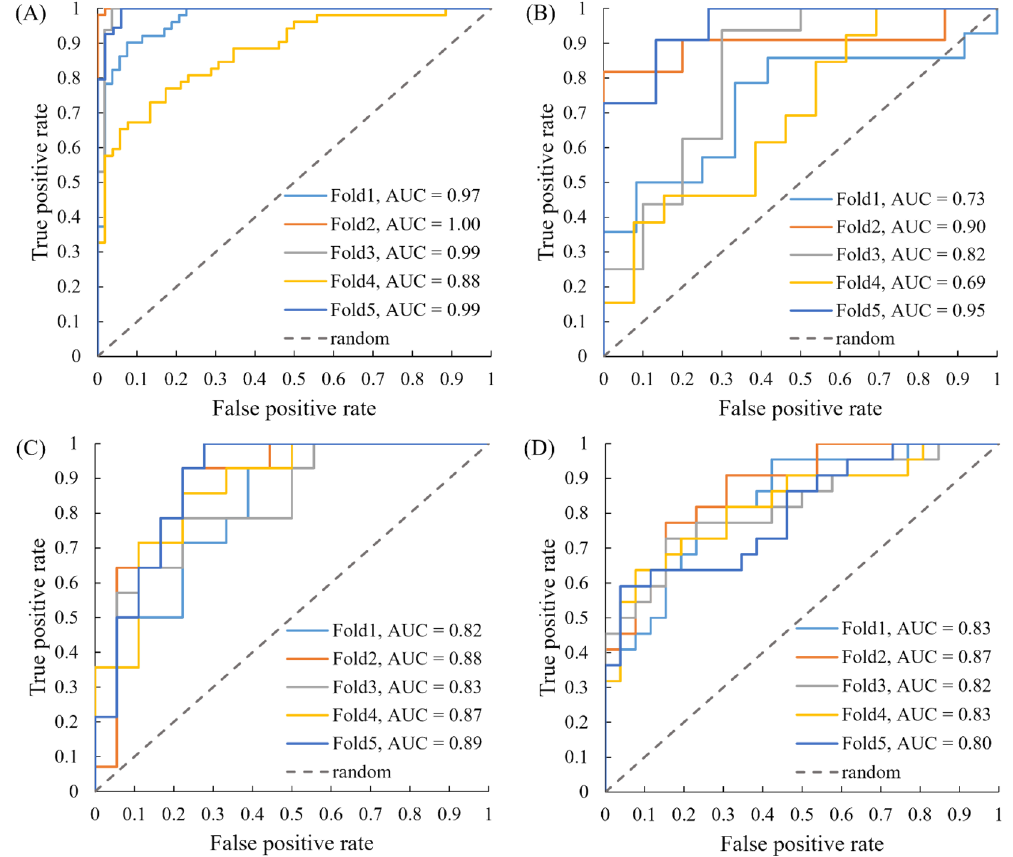
Figure 2. The receiver operating characteristic (ROC) plots and corresponding areas under the curves (AUCs) of each fold for the training ( A ), validation ( B ), retrospective independent testing ( C ), and prospective blinded testing ( D ) groups. The averaged AUCs for each group were 0.97, 0.82, 0.86, and 0.83, respectively. The training and validation groups were used to develop the deep learning network and determine the optimal operating thresholds.